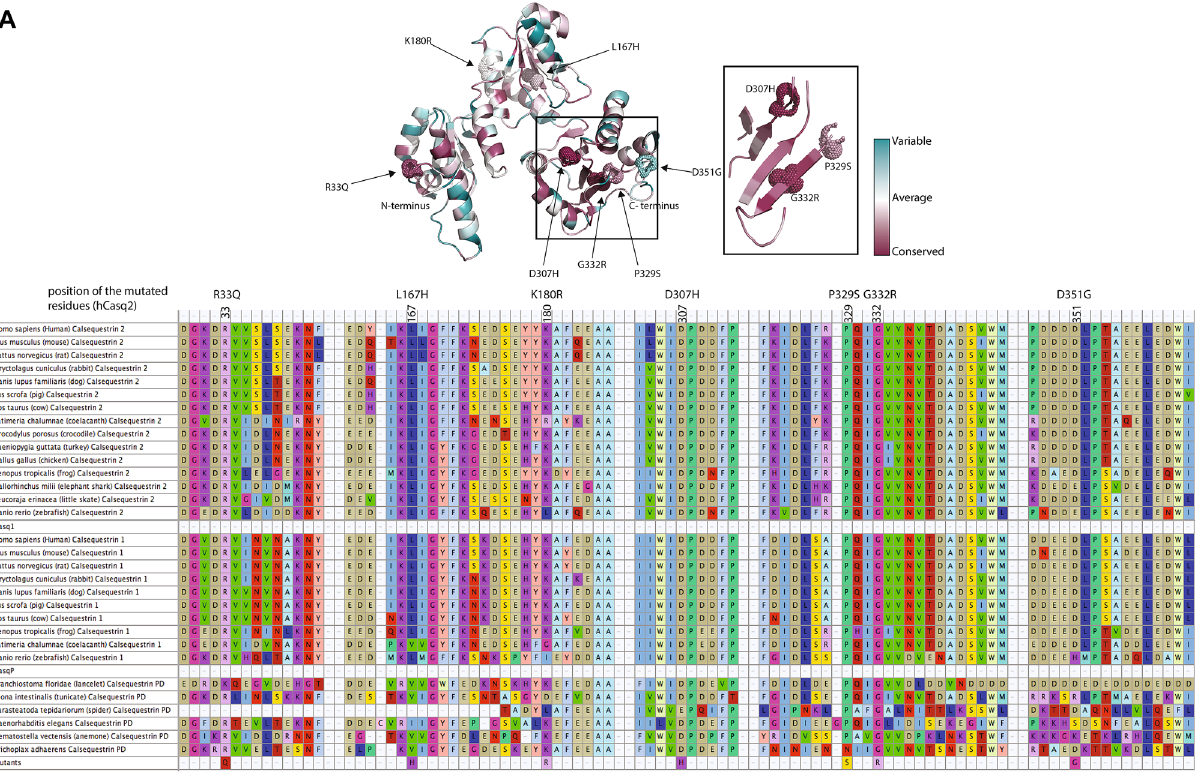
Figure 2. Amino acid sequence alignments and calsequestrin 3D structure. ( A ) The 3D structure of the cardiac isoform of calsequestrin (Casq2) is shown (2VAF). The location of R33Q, L167H, K180R, D307H, P329S, G332R, and D351G Casq2 mutants are depicted in the structure. A scale of variable to conserved residues is indicated in the Figure. Mutants are shown as dot sphere. The highly conserved beta-sheet from the third thioredoxin-like fold is enlarged in the box and shown separately. The table shows the alignment of calsequestrin amino acid sequences. The degree of conservation of Casq2 sequences is color-coded using ConSurf 71 . Multiple sequence alignments were inputed from the Casq1, Casq2, and Casqp alignment. Different colors represent similar/identical amino acid residues. The location of mutated residues is indicated in the table. hCASQ2, human Casq2. ( B ) Human Casq2 (PBD: 2VAF) with electrostatic potential surfaces. The location of the N- and C-terminus of Casq2 is indicated. Secondary structures are shown as green ribbons, the amino acid residues corresponding to the CPVT related mutations are indicated by the corresponding van der Waals surface as orange spheres. Local environments around R33, L167, K180, D307, P329, G332, and D351 residues are shown. Secondary structures are shown as green ribbons, dotted lines indicate a polar interaction between side-chains. Oxygen, nitrogen, and carbon atoms are shown in red, blue, and white, respectively. For G332, the hydrogens on α-carbon are shown in white. Prepared using PyMOL v2.4.1 (https ://www.pymol